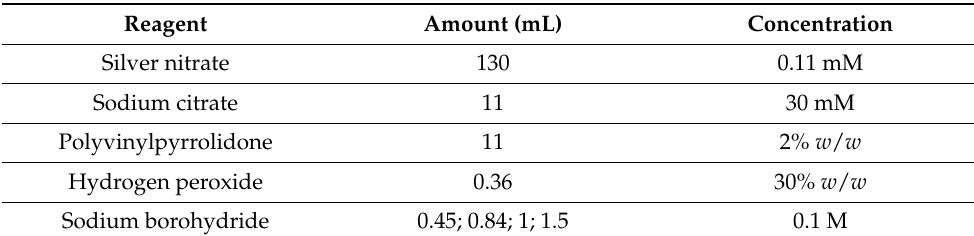
Table 1. Reagents